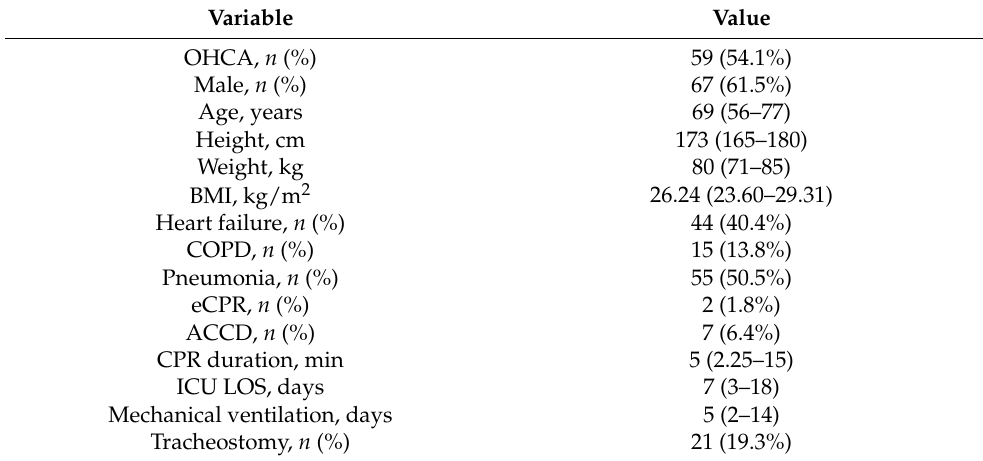
Table 1. Demographic characteristics of 109 patients with CPR-related chest injuries.